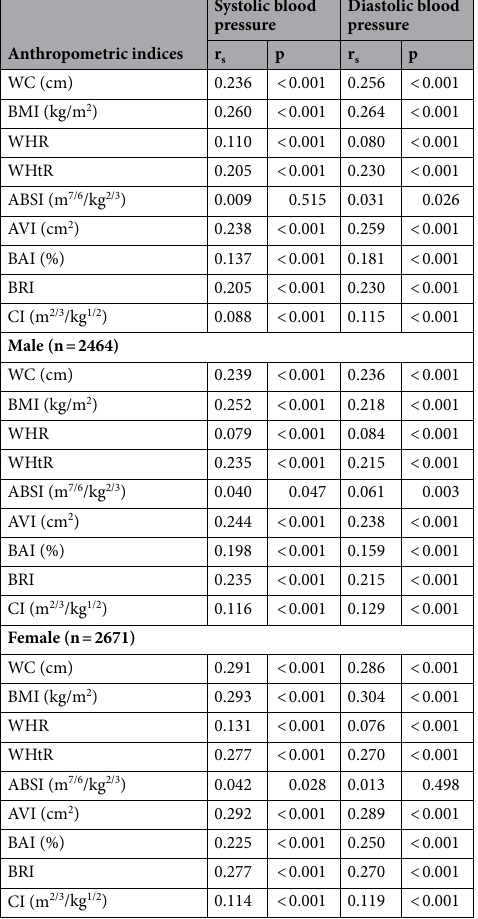
Table 3. Spearman’s correlation of individual anthropometric indices with blood pressure stratified by gender. WC waist circumference, BMI body mass index, WHR waist-to-hip ratio, WHtR waist to height ratio,